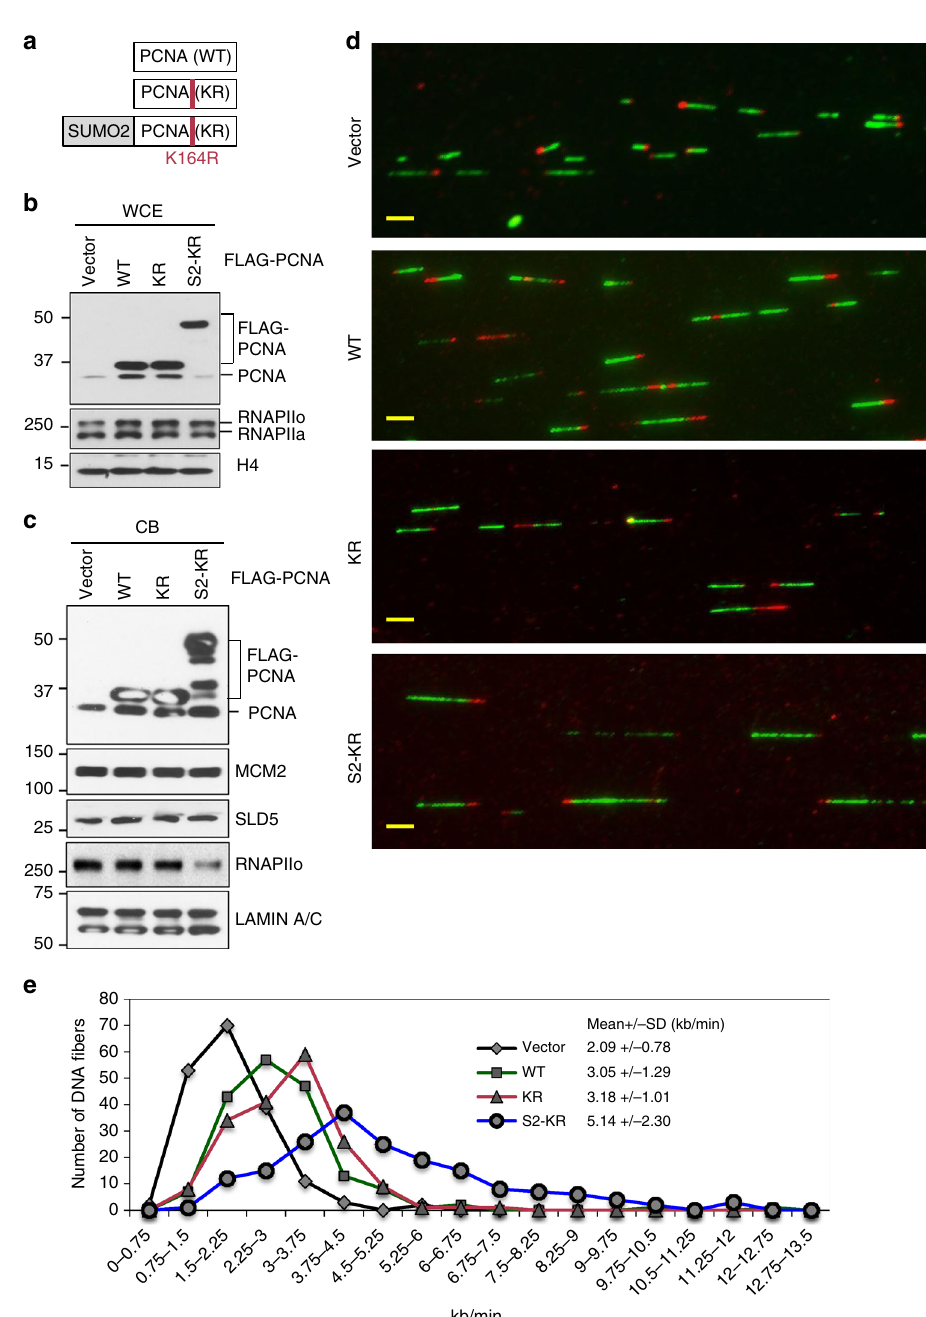
Fig. 2 SUMO2-PCNA enhances replication fork progression. a Schematic diagram of FLAG-PCNA WT, K164R (KR), and SUMO2-KR (S2-KR) fusion constructs. The location of KR mutation is shown in red. b Western blot analysis of PCNA and FLAG-PCNA WT, KR, and S2-KR using an α -PCNA antibody and an α -RNAPII A10 antibody in whole cell extracts (WCE) prepared from HEK293T cells overexpressing the indicated FLAG proteins. Histone H4 was used as a loading control. c Western blot analysis of the indicated proteins in the chromatin-bound (CB) fractions of the HEK293T cells overexpressing the indicated FLAG-PCNA proteins in b . H5 mouse monoclonal was used to detect RNAPIIo. d Representative fl uorescence images of DNA fi bers isolated from HEK293T cells overexpressing the indicated FLAG-PCNA proteins or transfected with an empty vector. Scale bar = 10 µ m. e Distributions of the replication fork processivity rates for HEK293T cells used in d overexpressing the indicated FLAG-PCNA proteins or transfected with an empty vector. Fiber length was measured based on a conversion factor of 1 µ m to 2.59 kb. Each average value ± standard deviation was calculated from at least 150 DNA fi bers per one representative experiment. The result was reproduced in two independent